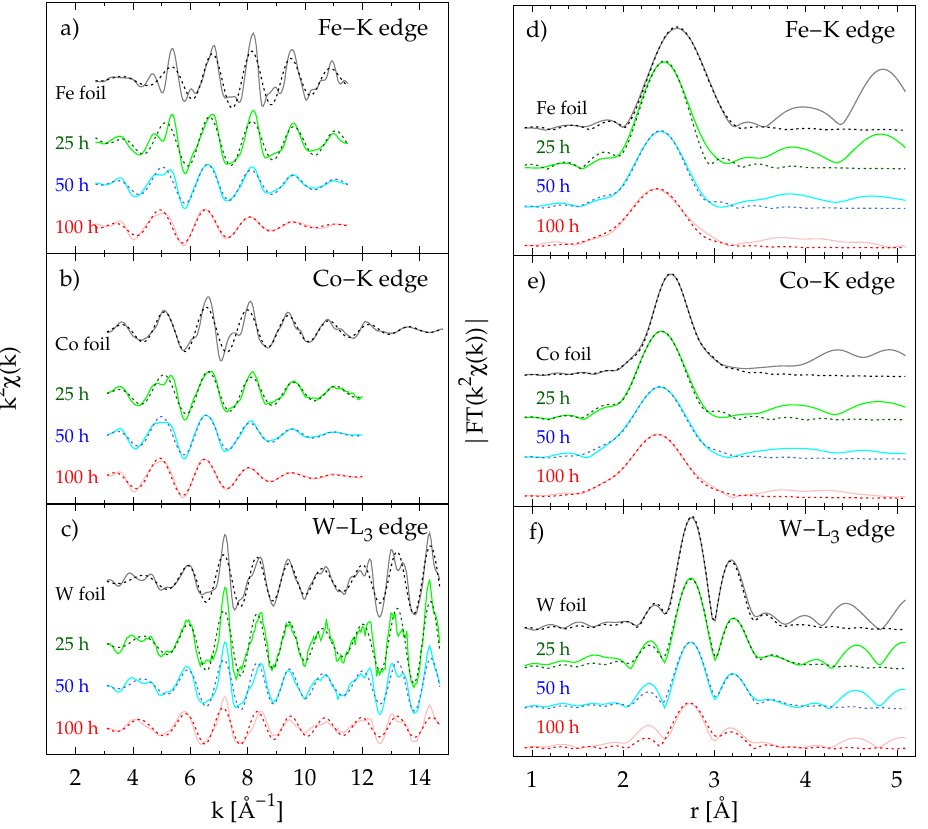
Figure 9. EXAFS signals k 2 χ ( k ) in k -space ( a – c ) and corresponding magnitudes of its Fourier transforms in r -space ( d – f ) as measured above Fe-K, Co-K and W-L 3 edges for the alloy CoFeWB after 25, 50 and 100 h of mechanical alloying. Solid lines correspond to experimental data, whereas dashed lines correspond to fitting curves based on the quick first shell model. Additionally, signals from reference foils are presented. For better clarity, curves are vertically offset. Table 3. Numerical results of fitting EXAFS data based on the first coordination shell model from measurements performed at the Fe-K and Co-K edges. The scatterer–absorber pairs are indicated, the partial coordination number N j , the path length R j and the mean square atomic displacement (cid:104) u 2 (cid:105) for all relevant samples are listed. Fe